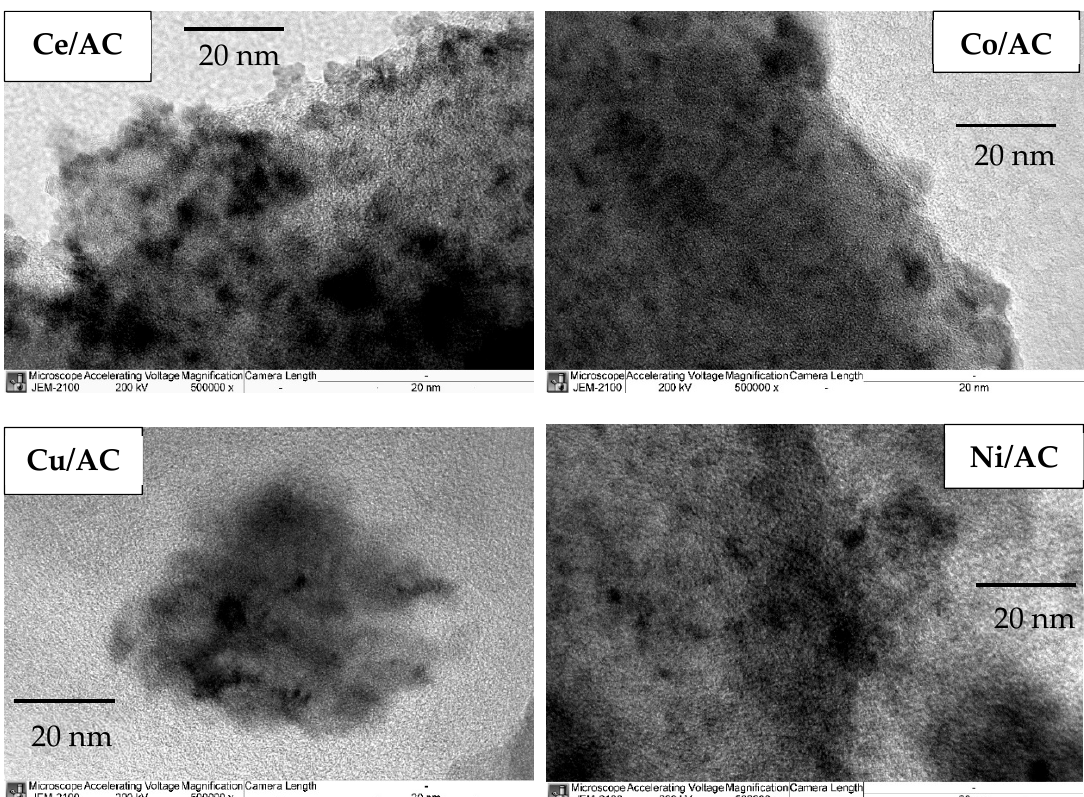
Figure 2. TEM images of activated carbon doped with different metal catalysts.